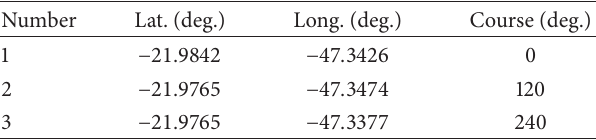
Table 1: List of